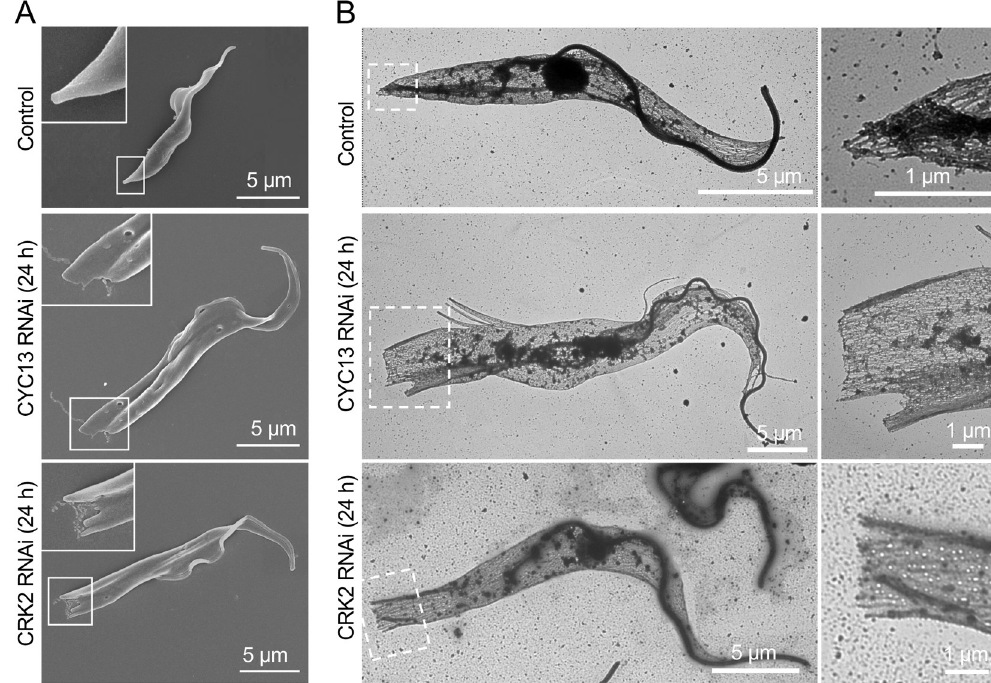
Fig 3. Knockdown of CYC13 or CRK2 impairs posterior microtubule convergence. ( A ). Scanning electron microscopic analysis of non-induced control cells, CYC13 RNAi cells, and CRK2 RNAi cells. Scale bars: 5 μ m. ( B ). Transmission electron microscopic (TEM) analysis of the subpellicular microtubules at the cell posterior. Shown are TEM images of negatively stained cytoskeletons of non-induced control cells, CYC13 RNAi cells, and CRK2 RNAi cells. The right panels show the enlarged images of the boxed areas in the respective left panels. Scale bars: 5 μ m and 1 μ m as indicated.